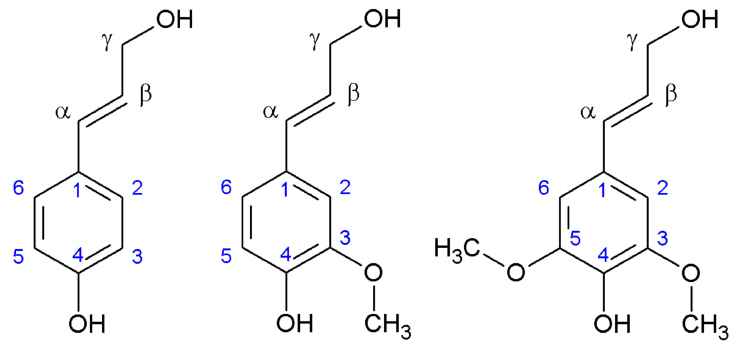
Figure 1. Main monolignol units. p-coumaryl alcohol, coniferyl alcohol and sinapyl alcohol, from left to right.